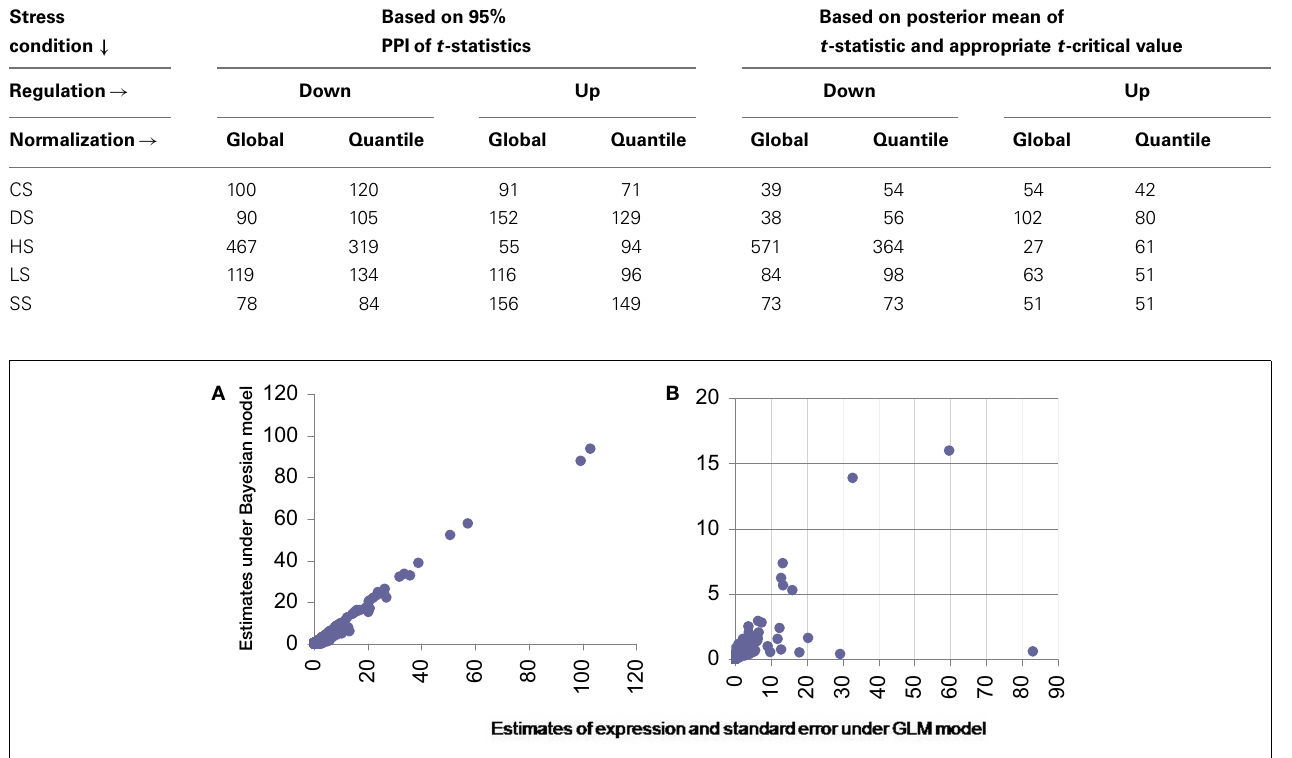
FIGURE 6 | Comparison of estimates from proposed Bayesian model ( Y -axis) and GLM ( X -axis). (A) Presents scatter plot of estimated expression levels for single transcript genes under the two methods while (B) presents the estimated standard error in these expression measurements from the same data under the same